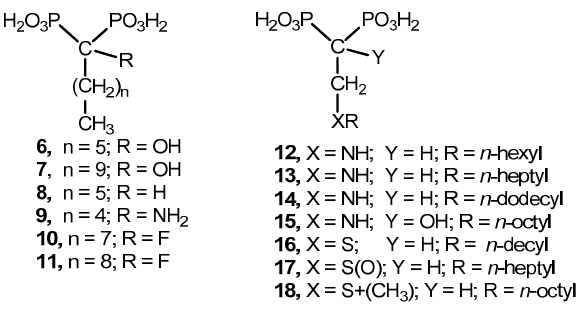
Figure 2. Chemical structures of representative lineal bisphosphonic acids as putative antiparasitic agents. Table 1. Biological activity of bisphosphonates previously prepared in our laboratory against T. cruzi (amastigotes), T. gondii (tachyzoites), Tc FPPS, and Tg FPPS.